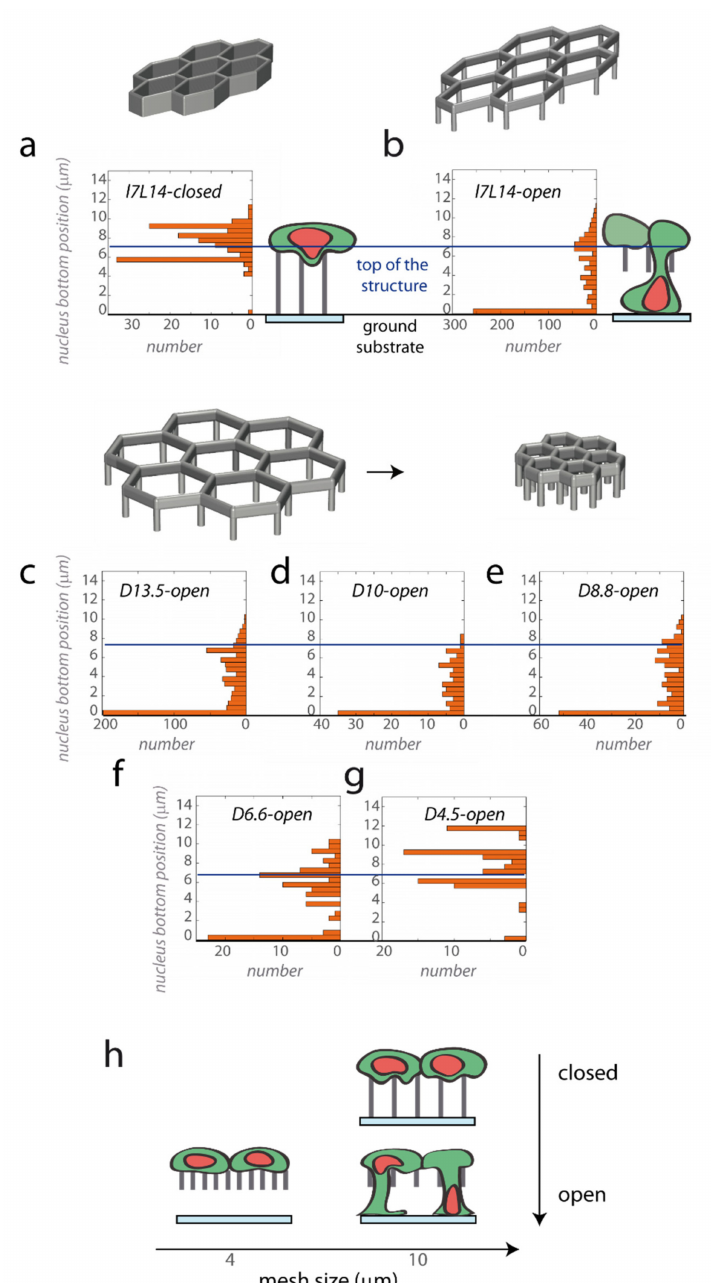
Figure 4. Dependence of geometry and pore size for nuclei engagement. HUVECs were cultivated on elongated ( a ) l7L14-closed microstructures (127 nuclei in 7 structures) and ( b ) l7L14-open structures (700 nuclei in 15 structures), or on regular open structures with different horizontal dimensions D : ( c ) D13.5-open (607 nuclei in 6 structures), ( d ) D10-open (95 nuclei in 1 structure), ( e ) D8.8-open , (178 nuclei in 4 structures), ( f ) D6.5-open (94 nuclei in 5 structures), and ( g ) D4.5-open (77 nuclei in 7 structures). After the 3D segmentation of nuclei, the position of the bottom of the nuclei was determined, with a position of 0 µ m corresponding to the contact with the bottom substrate (black horizontal line) and a position of 7 µ m to the top of the microstructures (blue horizontal line). For D4.5-open microstructures ( g ), the highest position compared with the expected height of the struc- ture likely reflects an optical deformation when imaging through a densely polymerized structure. ( h ) Recapitulative scheme showing nuclei engagement in the function of the pore size and on the closed or open nature of the